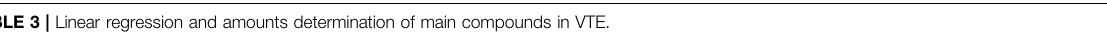
TABLE 3 | Linear regression and amounts determination of main compounds in VTE.